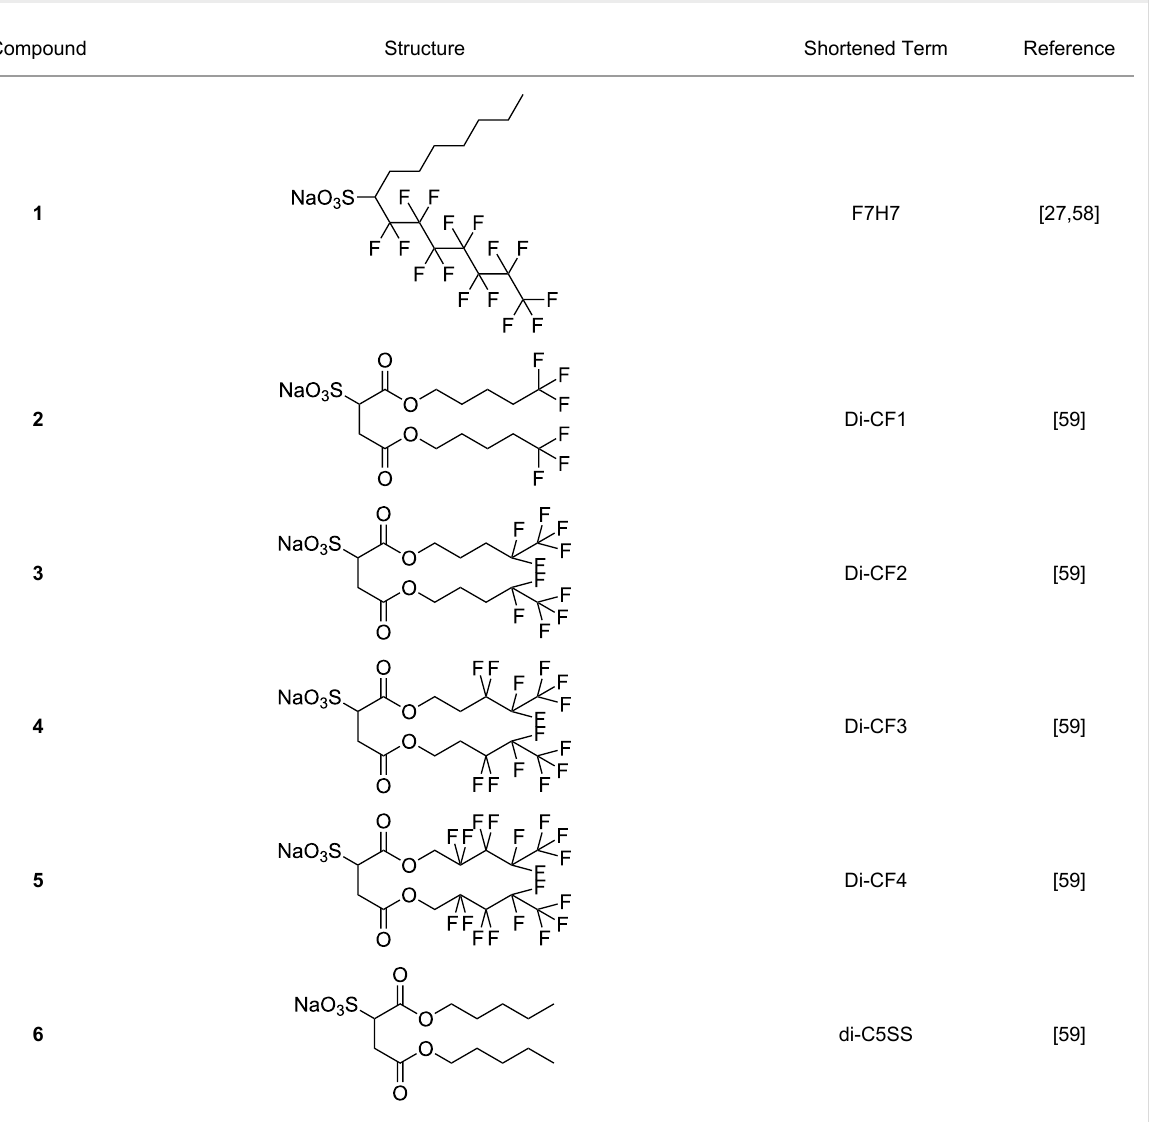
Table 1: Structures of CO 2 -philic surfactants discussed in this review.